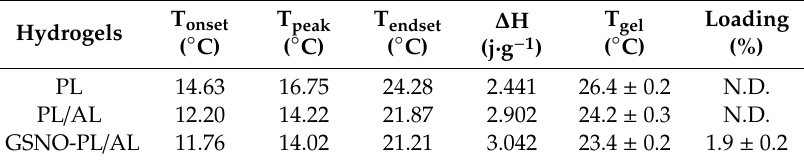
Figure 2. ( A ) Temperature ramp test of PL/AL and GSNO-PL/AL. Changes of storage modulus (G′) and loss modulus (G″) as the temperature changes. ( B ) Differential scanning calorimetry (DSC) thermographs of PL, PL/AL, and GSNO-PL/AL hydrogels. Table 1. Characterization of the hydrogels.